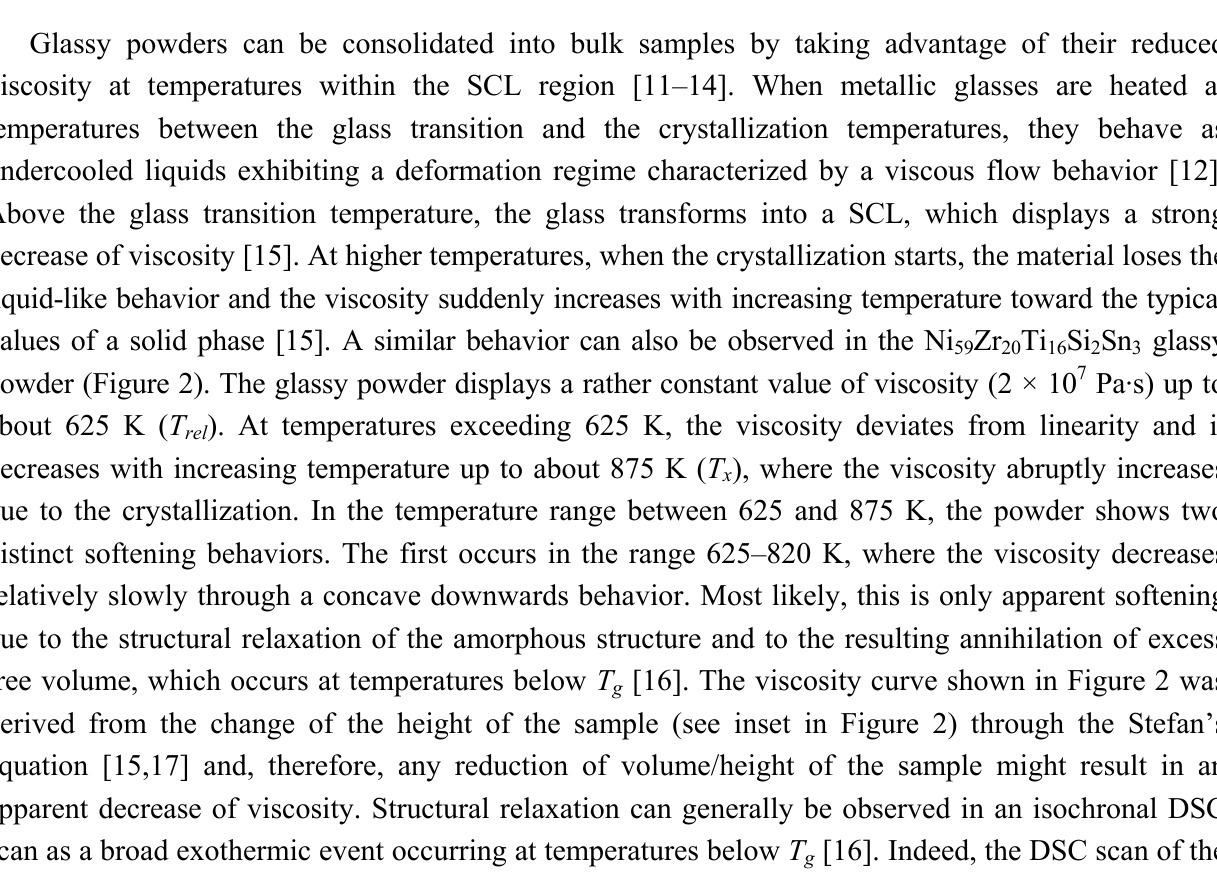
Figure 1. ( a ) DSC scans (heating rate 30 K/min) of the as-atomized Ni powder (100 vol.% glass) and brass-matrix composites with 60 and 40 vol.% of glass reinforcement; ( b ) broad exothermic event below T